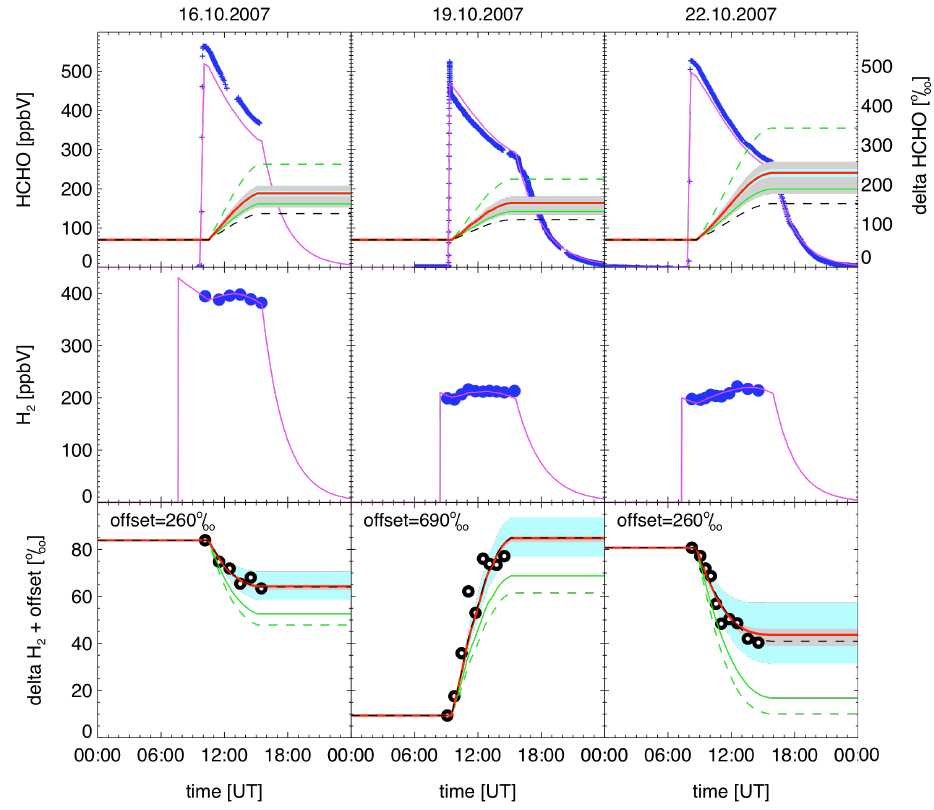
Fig. 2. Experimental and model results of the formaldehyde photolysis experiments in the SAPHIR chamber. Top panels show the concentra- tion (left scale) and isotopic composition (rights scale) of formaldehyde. Middle panels show the H 2 concentration, bottom panels show the isotopic composition of H 2 , shifted in positive direction by the listed offsets in order to subtract the effect from the different bath gases used. Symbols represent measurement results (blue: concentration, black: δ D). Lines represent model results as follows: pink: concentration; red: δ D for KIE rad = KIE mol = 1.63 (line 1 in Table 2); grey shaded area: KIE rad varied by ± 0.5; light blue shaded area: KIE mol varied by ± 0.1; black dashed line: KIE rad =1.00, KIE mol = 1 . 60 (line 8 in Table 2); green solid line: Feilberg et al. (2007b); green dashed line: Rhee et al. (2008).